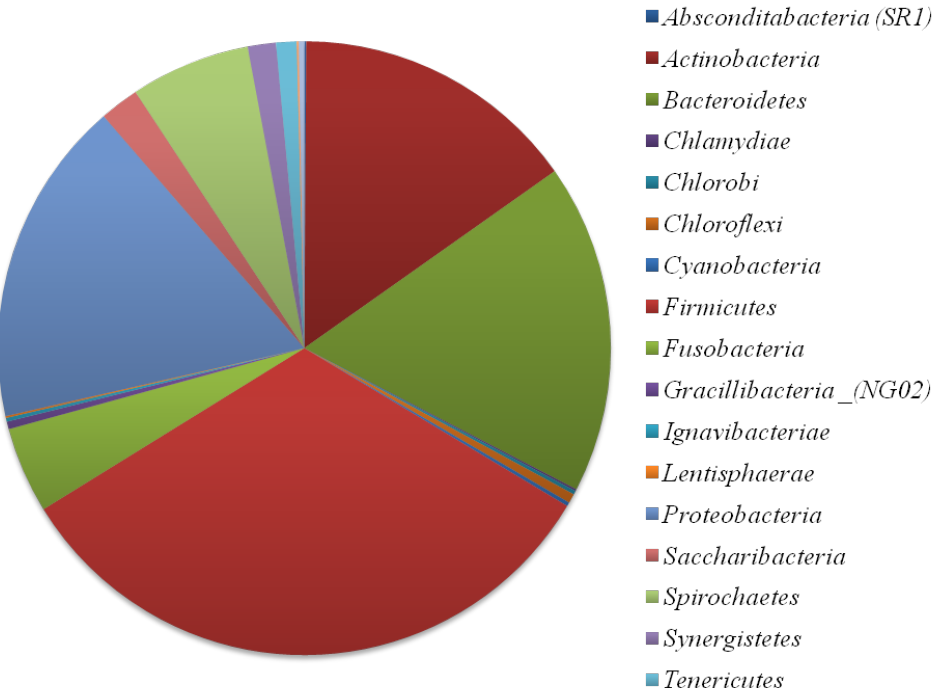
Figure 2. Quantitative distribution of cultured and uncultured bacterial diversity composing the oral microbiota represented by number of species composing each phylum. Each phylum is represented by a different colour, as shown on the right. (Figure 2 was built according to data collected from the Human Oral Microbiome Database; https://www.homd.org/; accessed on 23 January 2023).